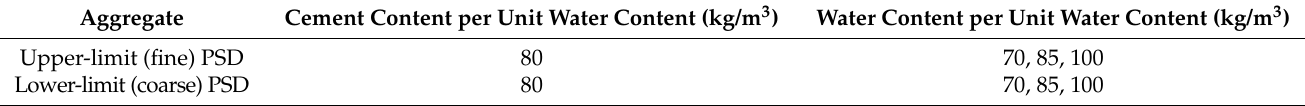
Table 2. Mix ratios for large specimen.